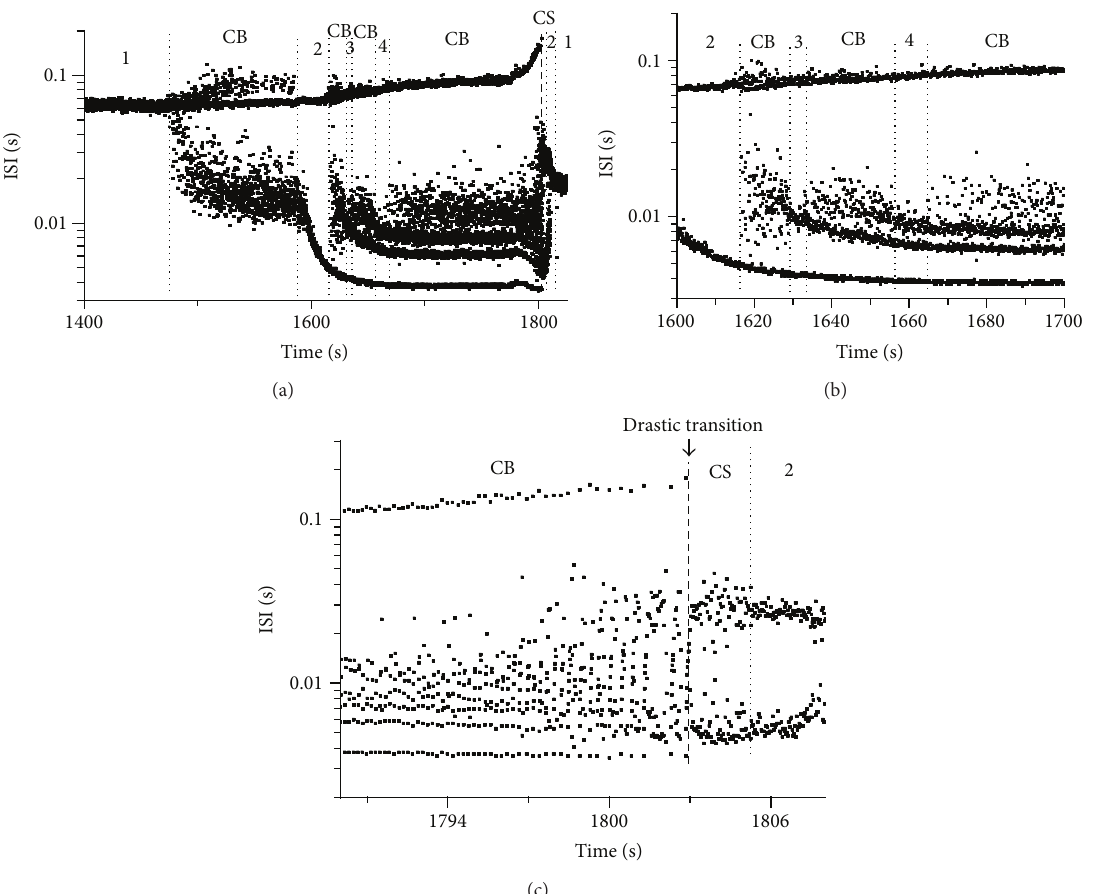
Figure 4: Example 1 of bifurcation process from period-1 bursting to period-1 spiking. (a) In detail, the process lasts from period-1 bursting to chaotic bursting to period-2 bursting to chaotic bursting to period-3 bursting to chaotic bursting to period-4 bursting to chaotic bursting to chaotic spiking to period-2 spiking to period-1 spiking. (b) Detail of Figure 4(a), which involves period-adding bifurcation with chaos from period-2 bursting to chaotic bursting after period-4 bursting. (c) Detail of Figure 4(a), which involves chaotic bursting to chaotic spiking to period-2